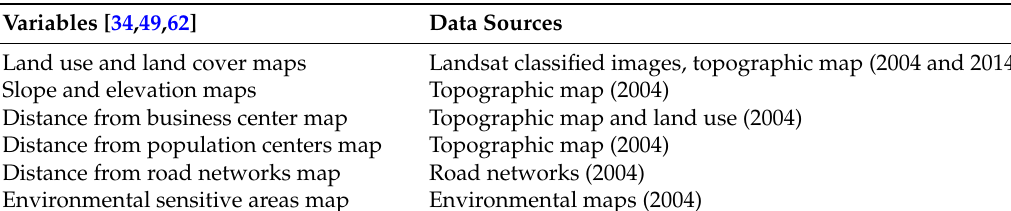
Table 1. Effective factors in urban growth process.